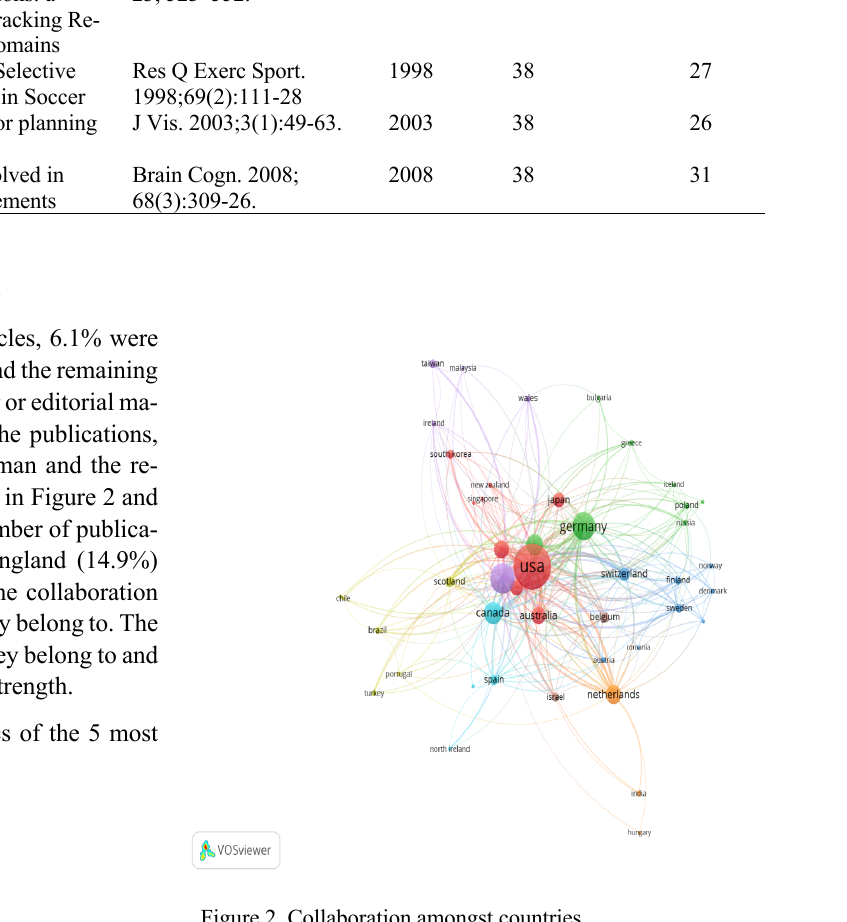
Figure 2. Collaboration amongst